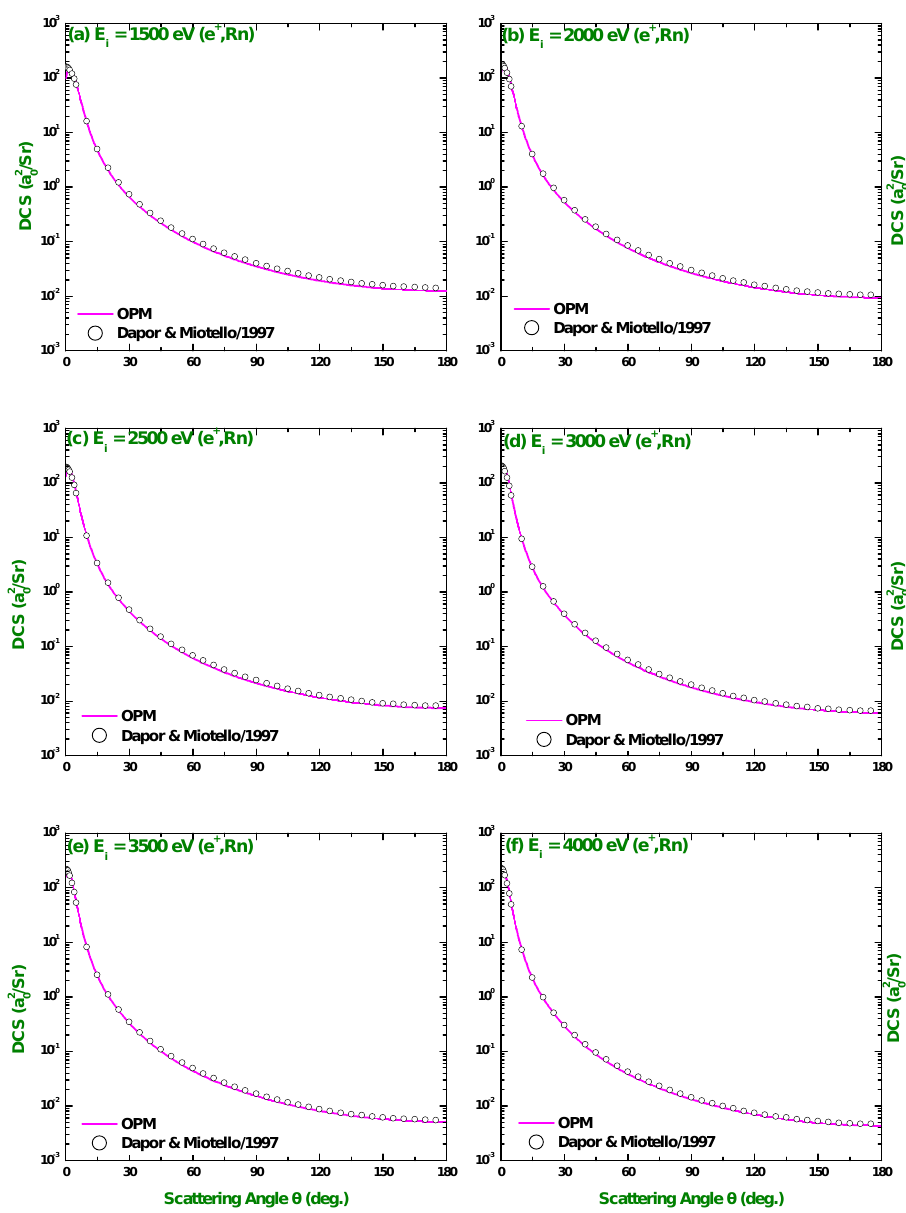
Figure 21. Same as Figure 19, but at impact energies of 1500, 2000, 2500, 3000, 3500 and 4000 eV. ◦ ◦ ◦ curves are the calculations of Dapor and Miotello